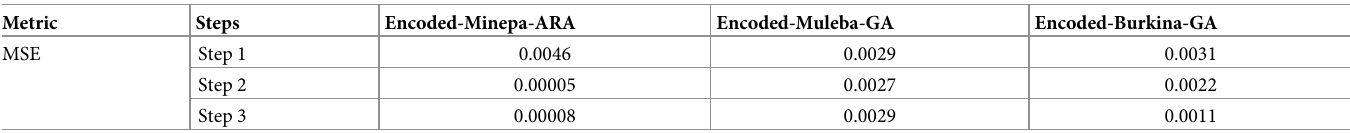
Table 1. Accuracies of reconstructing original feature spaces from encoded feature spaces. MSE = mean square error.